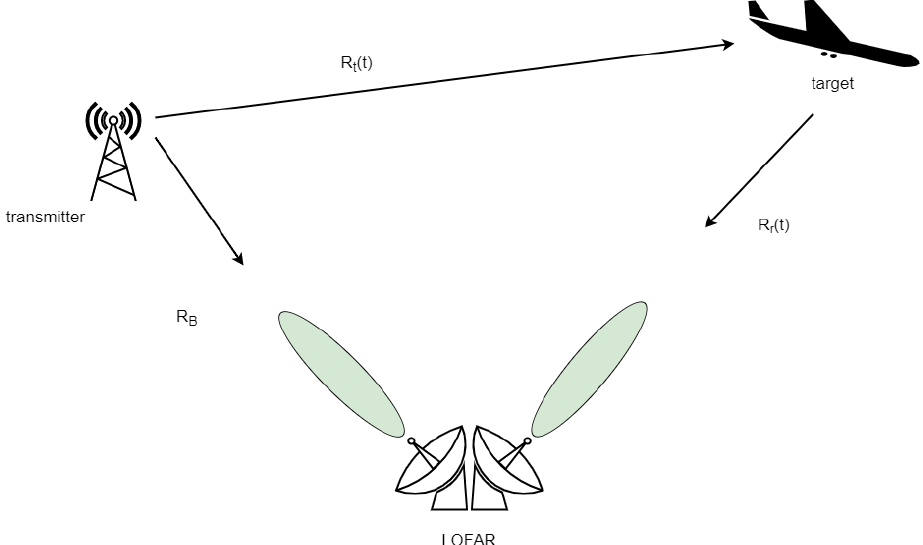
Figure 5. Passive radiolocation